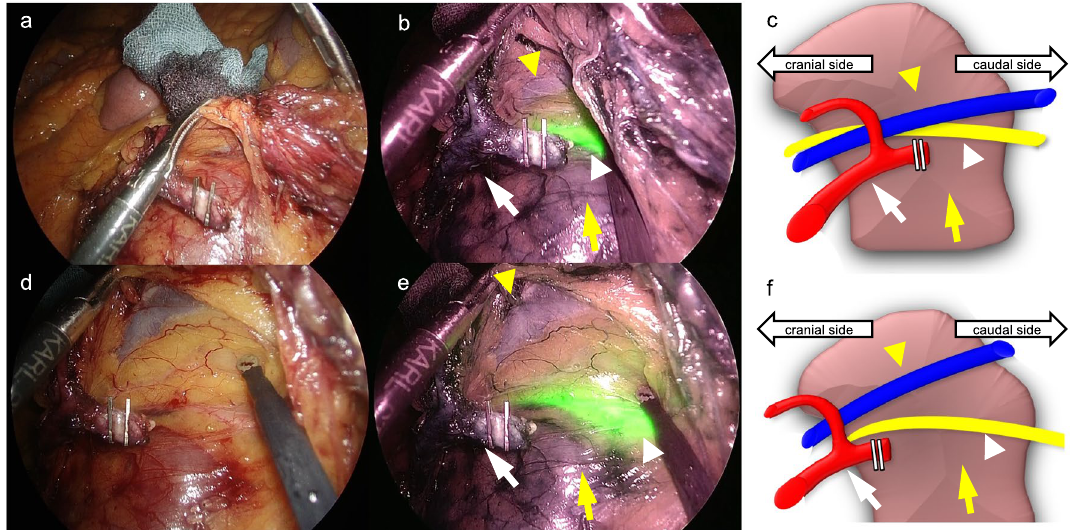
Fig. 3 Intraoperative findings showing the ability of using a fluorescent ureteral catheter to visualize the ureter. a A white light image in the beginning of mobilizing the descending and sigmoid colons via a medial approach: the location of the left ureter is unclear. b A near-infrared light image in the beginning of mobilizing the descending and sigmoid colons via a medial approach: the left ureter was identifiable using the fluorescent ureteral catheter. c A schema in the beginning of mobilizing the descending and sigmoid colons via a medial approach. d A white light image during mobilizing the descending and sigmoid colons via a medial approach. e A near-infrared light image during mobilizing the descending and sigmoid colons via a medial approach. f A schema during mobilizing the descending and sigmoid colons via a medial approach. The left ureter (white arrowhead), inferior mesenteric artery (white arrow), inferior mesenteric vein (yellow arrowhead), and renal isthmus (yellow arrow) are